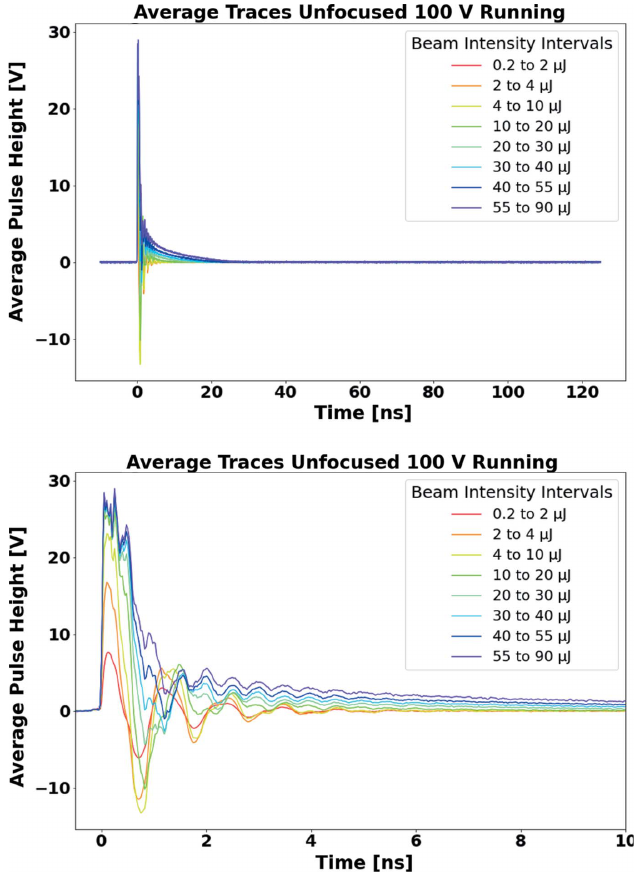
Figure 7 Average temporal signal profiles observed with the SCIPP assembly, in bins of delivered pulse intensity. The top plot shows the full 150 ns digitization window (for ease of comparison with the signal from the Sydor assembly); the bottom plot shows the pulse behaviour over the first 10 ns of the excitation. To maintain a signal at the oscilloscope digitizer within the dynamic range 0–1 V, RF attenuators of known value were added, as needed, to the signal path. Here, pulse heights are adjusted to account for signal-path attenuation, so the vertical axis represents the magnitude of the signal pulse across the shunt resistance.